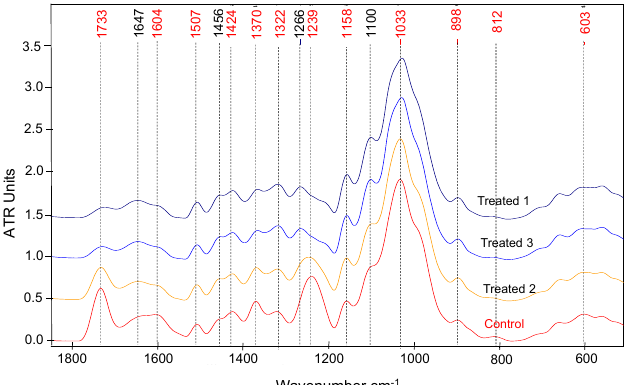
Figure 7. FTIR analysis of the treated and untreated Calotropis fibres (comparative spectra in fingerprint region 1800 cm − 1 –600 cm − 1 ). For the treated Calotropis fibre (sample 2), the spectrum was quite similar to the control sample, with some differences in the intensity of some characteristic absorptions, as follows: slight increase of –OH absorption band at 3300 cm − 1 ; a slight decrease of ab- sorptions at 1733 cm − 1 and 1370 cm − 1 , corresponding to the decrease of hemicelluloses content; the increase of absorption at 1645 cm − 1 , which becomes evident whilst the former absorption peak at 1604 cm − 1 decreased to a shoulder, possibly indicating some changes